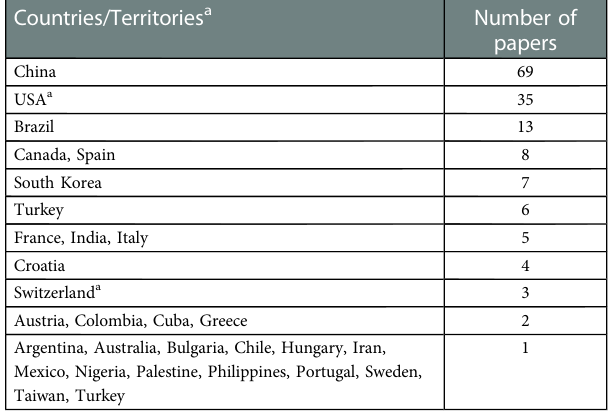
TABLE 1 Distribution of fi rst authors ’ country af fi liations in the bibliometrics of the pain literature. Countries/Territories